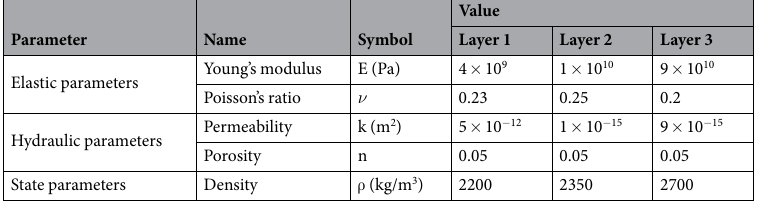
Table 1. Elastic, hydraulic and state parameters that were adopted in the numerical